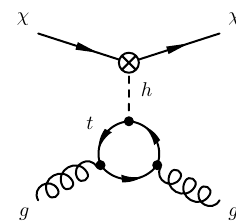
Figure 12 . Matching contributions to dimension-seven e(cid:11)ective operators involving gluons for (cid:22) < m Z that arise from integrating out the top